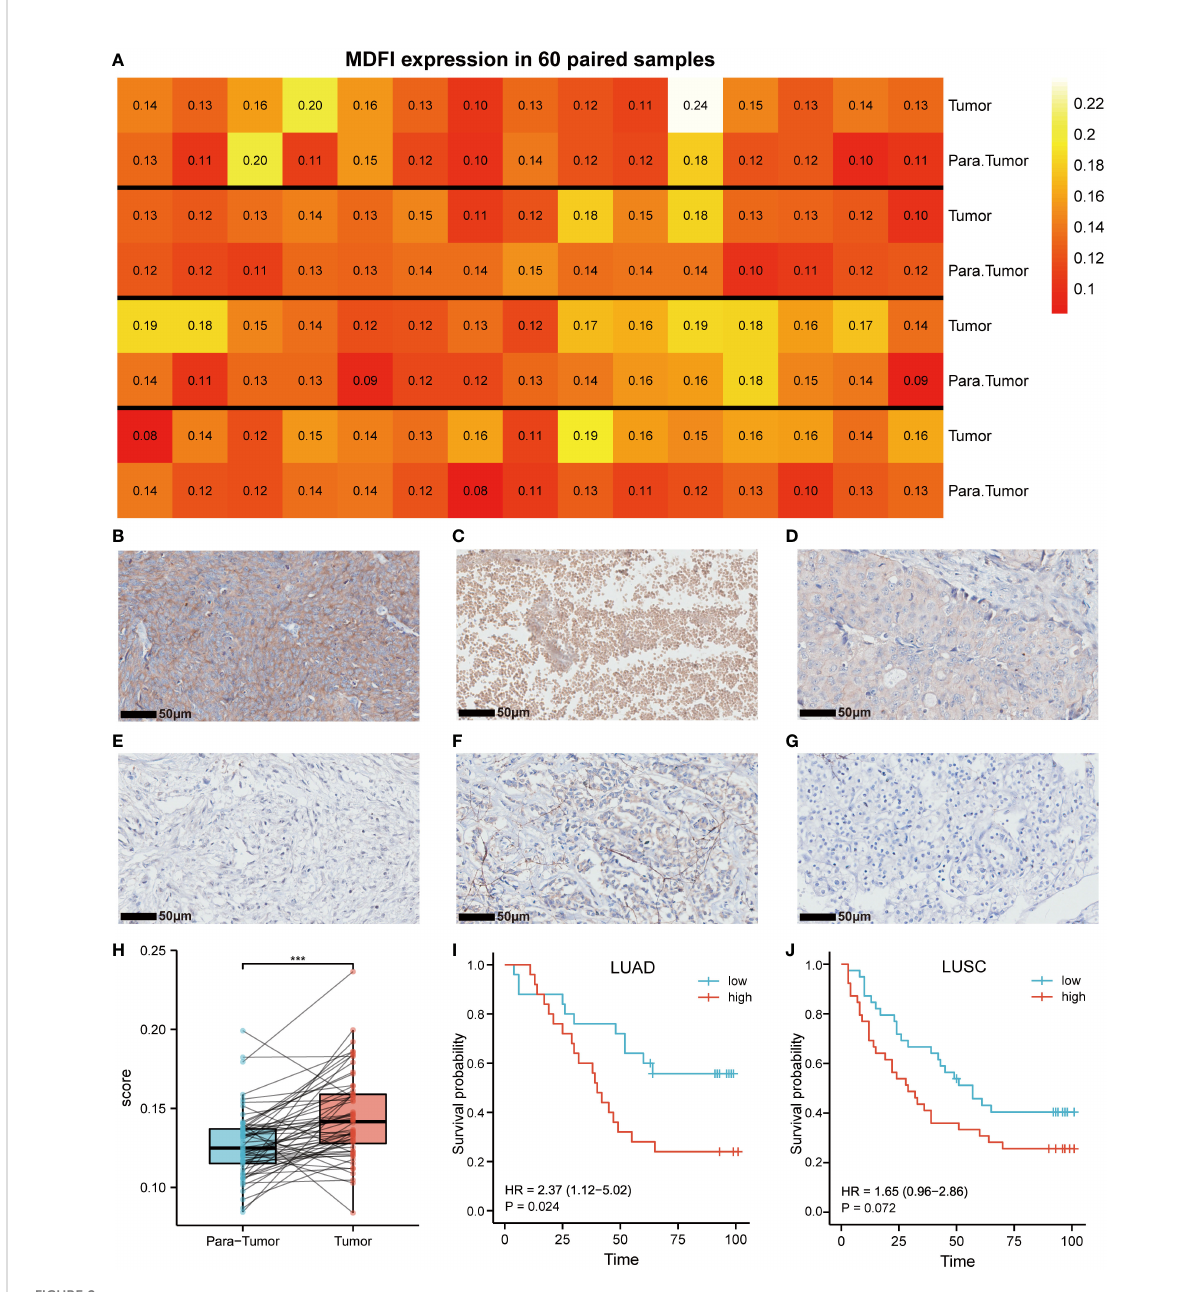
FIGURE 2 Expression of MDFI in tumor tissues. (A) Heat map of MDFI expression in 60 pairs of samples, (B) High expression of MDFI in lung cancer tissues, (C) MDFI is moderately expressed in lung cancer tissues, (D) Low expression of MDFI in lung cancer tissues, (E) Unstained normal tissue, (F) MDFI staining in invasive breast cancer tissue, (G) MDFI staining in clear cell renal cell carcinoma tissue, (H) Box plot of MDFI expression in 60 pairs of paired samples, (I) Prognastic analysis of MDFI in LUAD specimens, (J) prognostic analysis of MDFI in LUSC specimens, ***p <